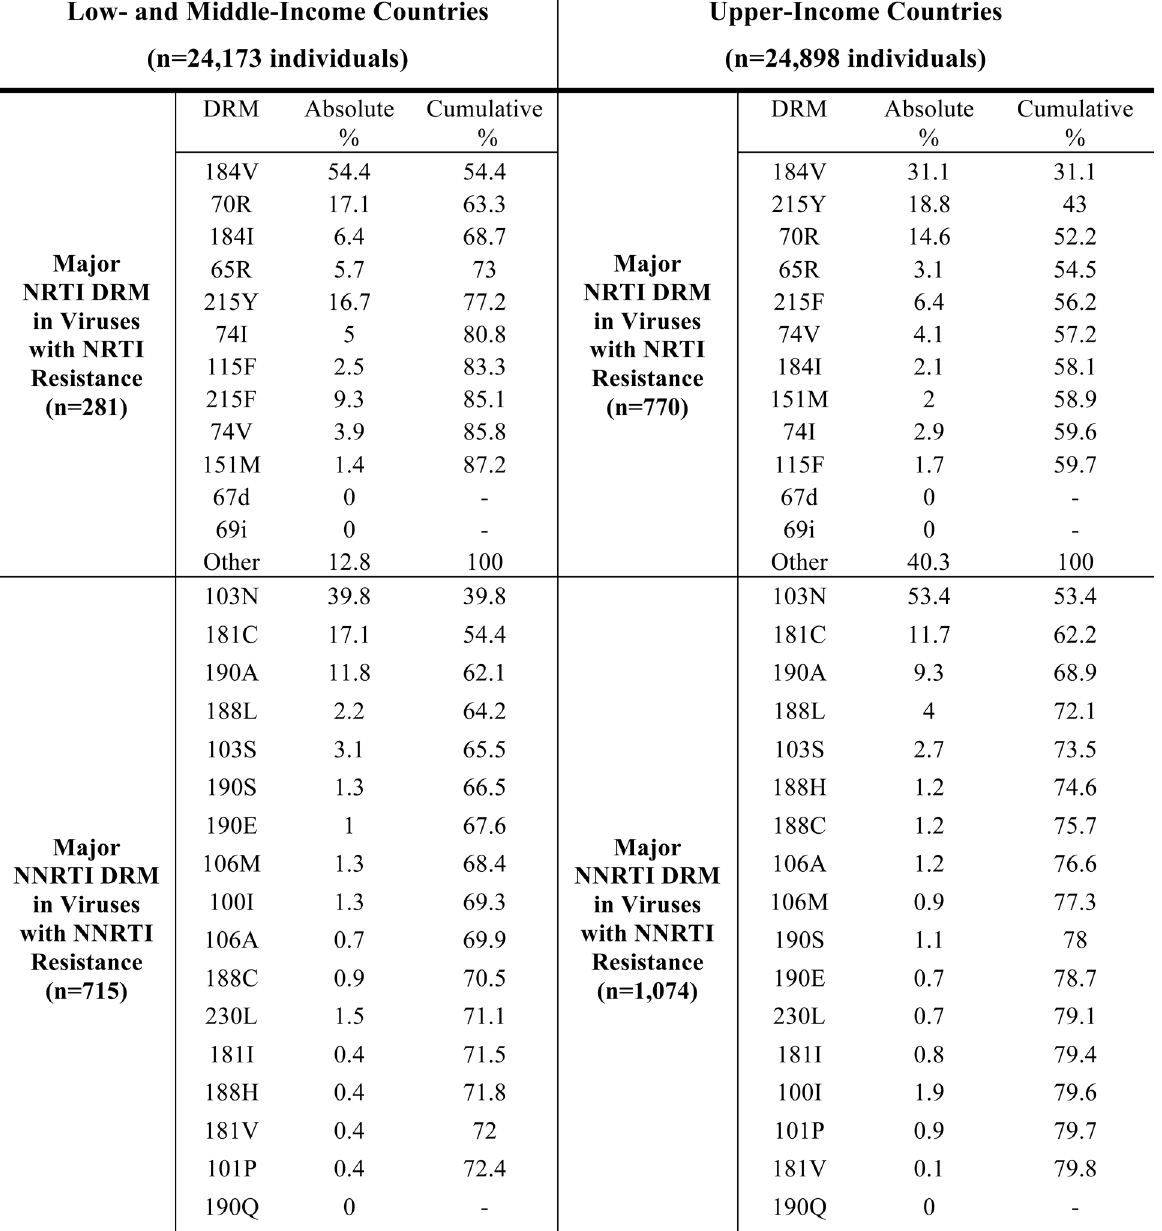
PLOS ONE | DOI:10.1371/journal.pone.0145772 December 30,